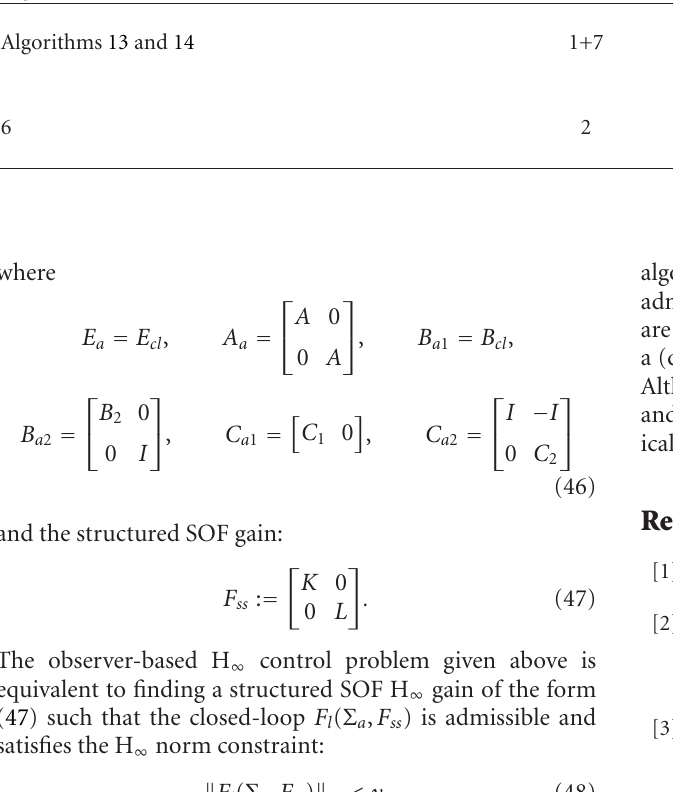
Table 2: A structured SOF H ∞ control problem ( γ = 1).